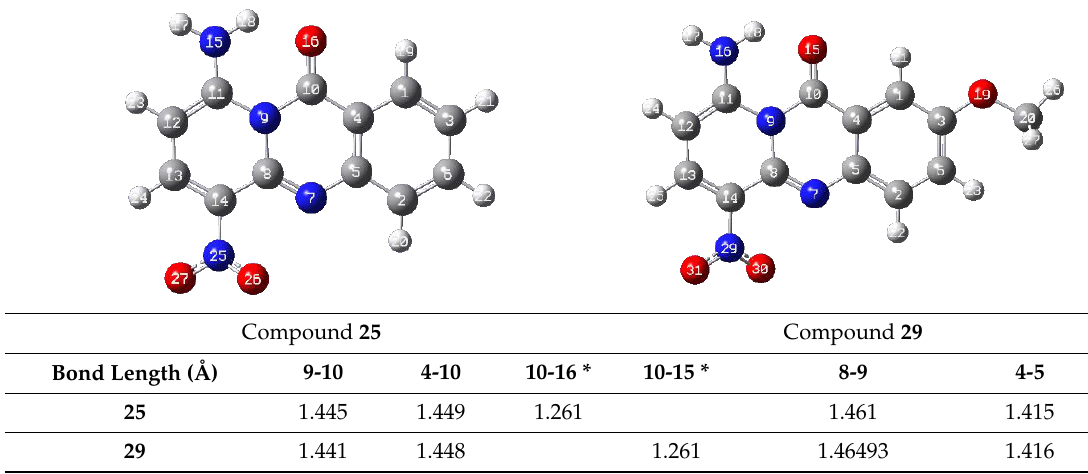
Table 3. Selected geometry characteristics of compounds 25 and 29 describing the lactam as well as its adjacent bonds based on DFT B3LYP 6-31G+. The two molecular structures show only subtle differences.